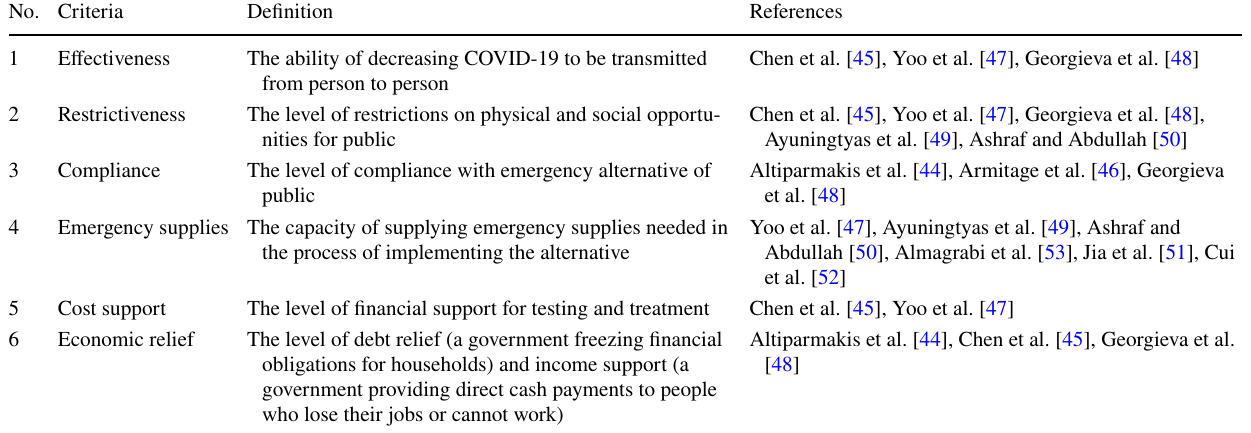
Table 1 Optional evaluation criteria for emergency alternatives No.